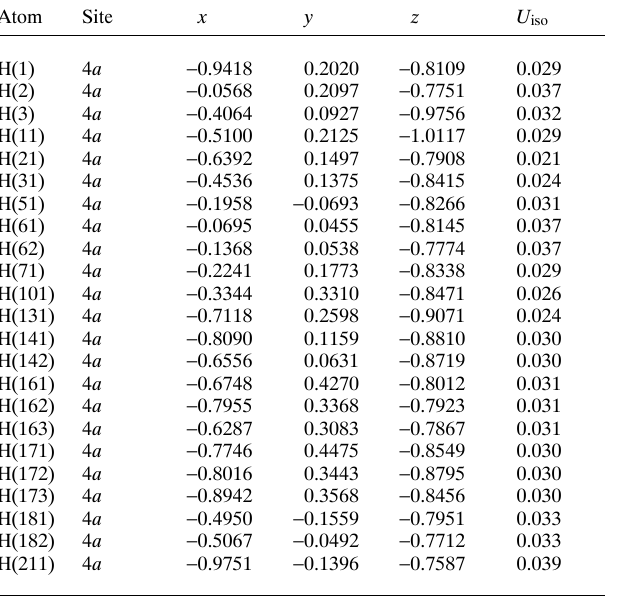
Table 2. A tomic coordin a tes a nd displ a cement p a r a meters (in Å 2 ) .